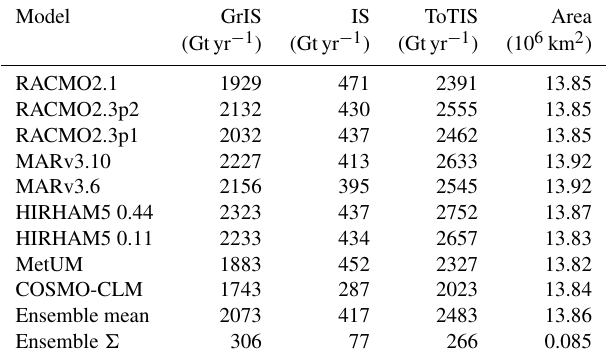
Table 3. Integrated mean annual SMB for the six models used in this study for the period 1980 to 2010 except for COSMO-CLM 2 , where the period was 1987 to 2010. Three older model versions, ensemble mean, and standard deviation as shown in Fig. 5. All calculations done on the original grid of the individual models using a common set of drainage basins and ice mask defined by IMBIE2 (IMBIE2 is the second assessment by the ice mass budget intercomparison exer- cise, published by Shepherd et al., 2020). The ensemble mean was calculated by transforming all models to the RACMO2.3p2 grid. GrIS denotes grounded ice sheet, IS denotes ice shelf, and ToTIS denotes the full AIS including ice